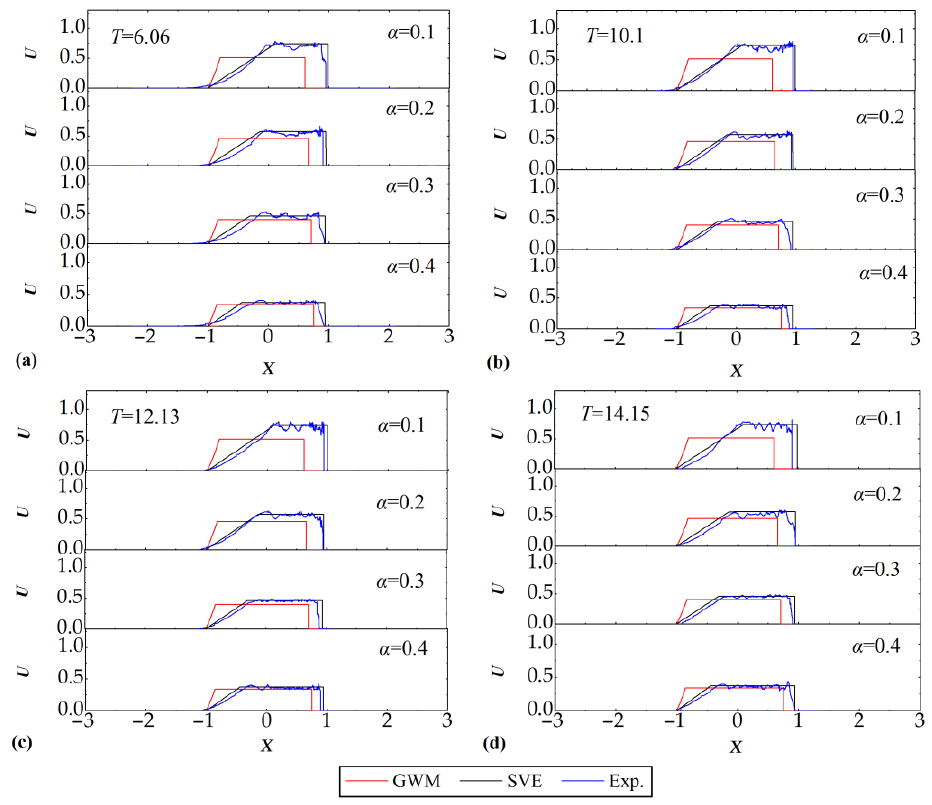
Figure 10. Average velocity for wet bed downstream: ( a ) T = 6.06; ( b ) T = 10.1; ( c ) T = 12.13; ( d ) T = 14.15.